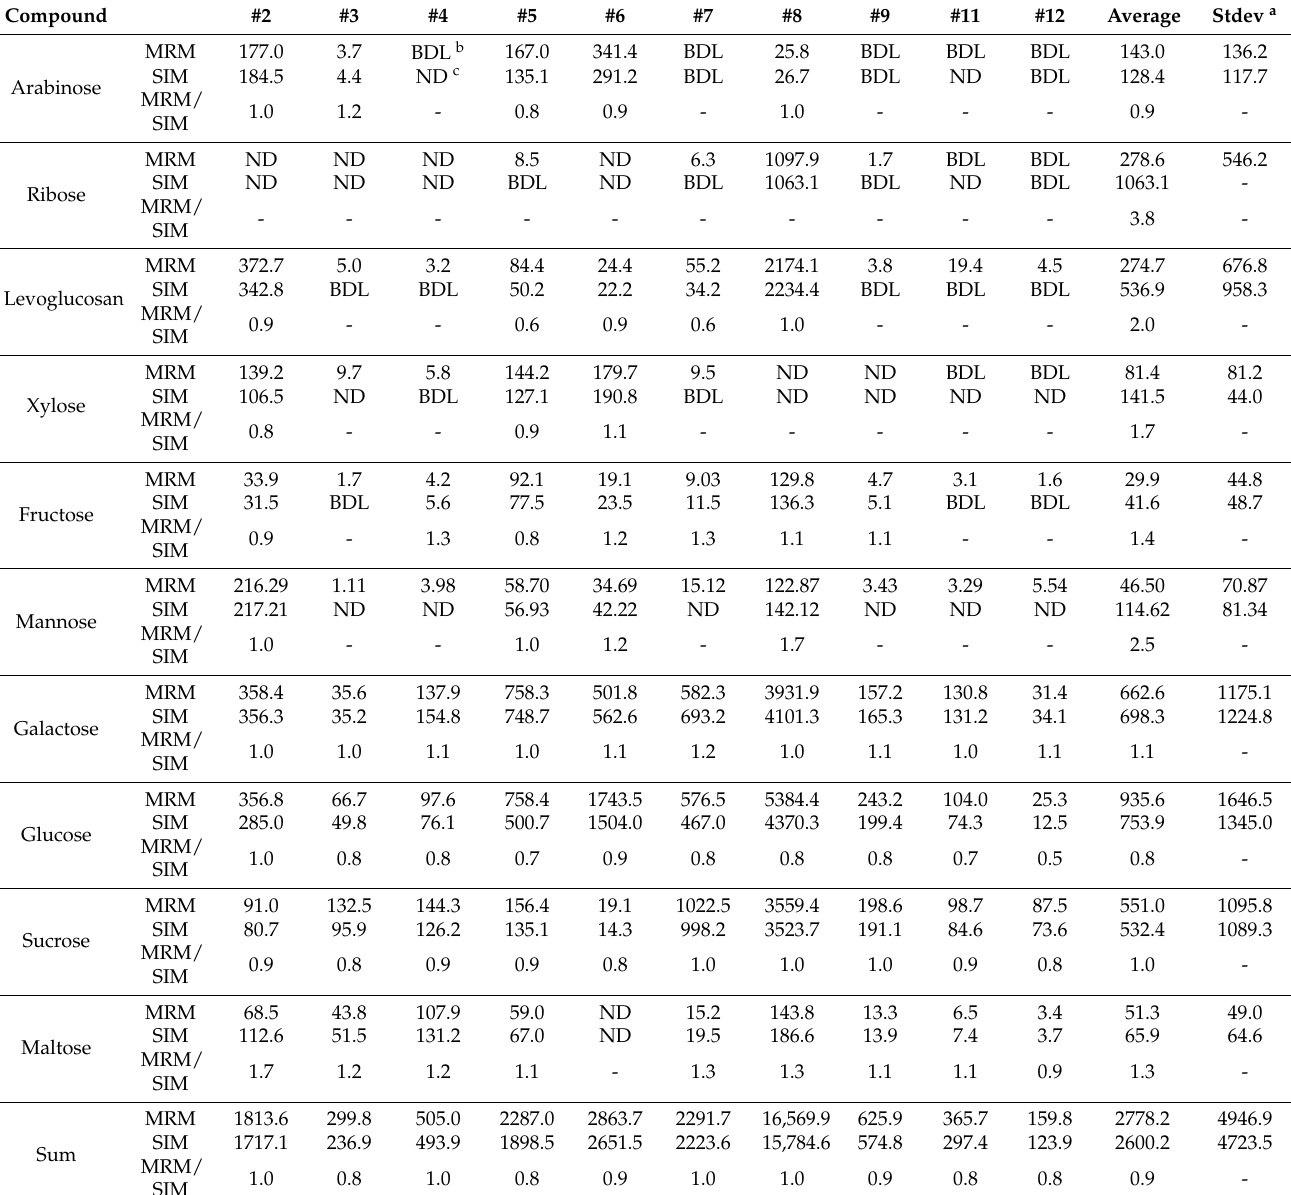
Table 8. Concentrations of target saccharides in samples collected on the Araon using GC-MS/MS in MRM mode and GC-MS in SIM mode (unit: pg/m 3 ) and the differences in concentration between the two modes. Samples were collected while sailing from Incheon, South Korea, to the Antarctic